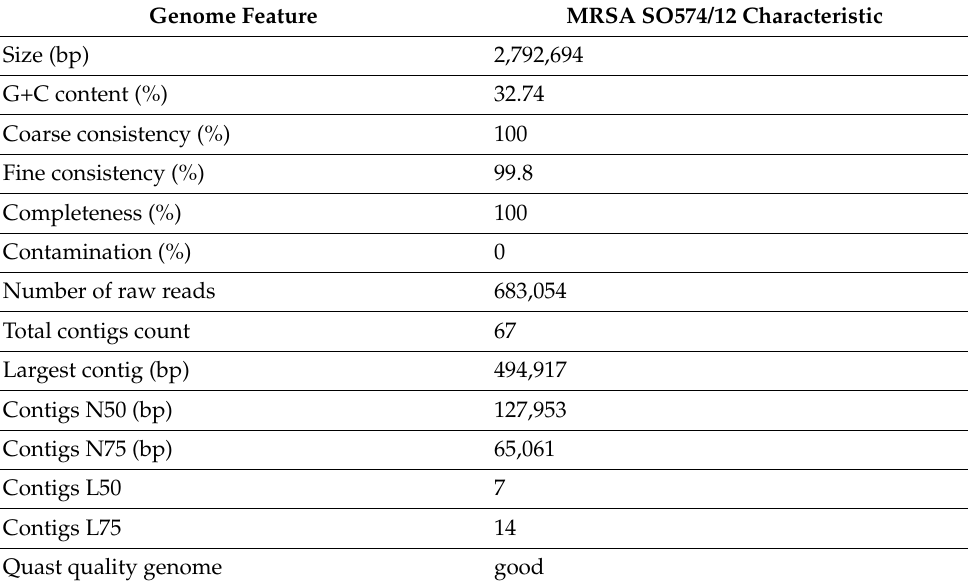
Table 3. Main assembling and annotation data for genome of MRSA SO574/12